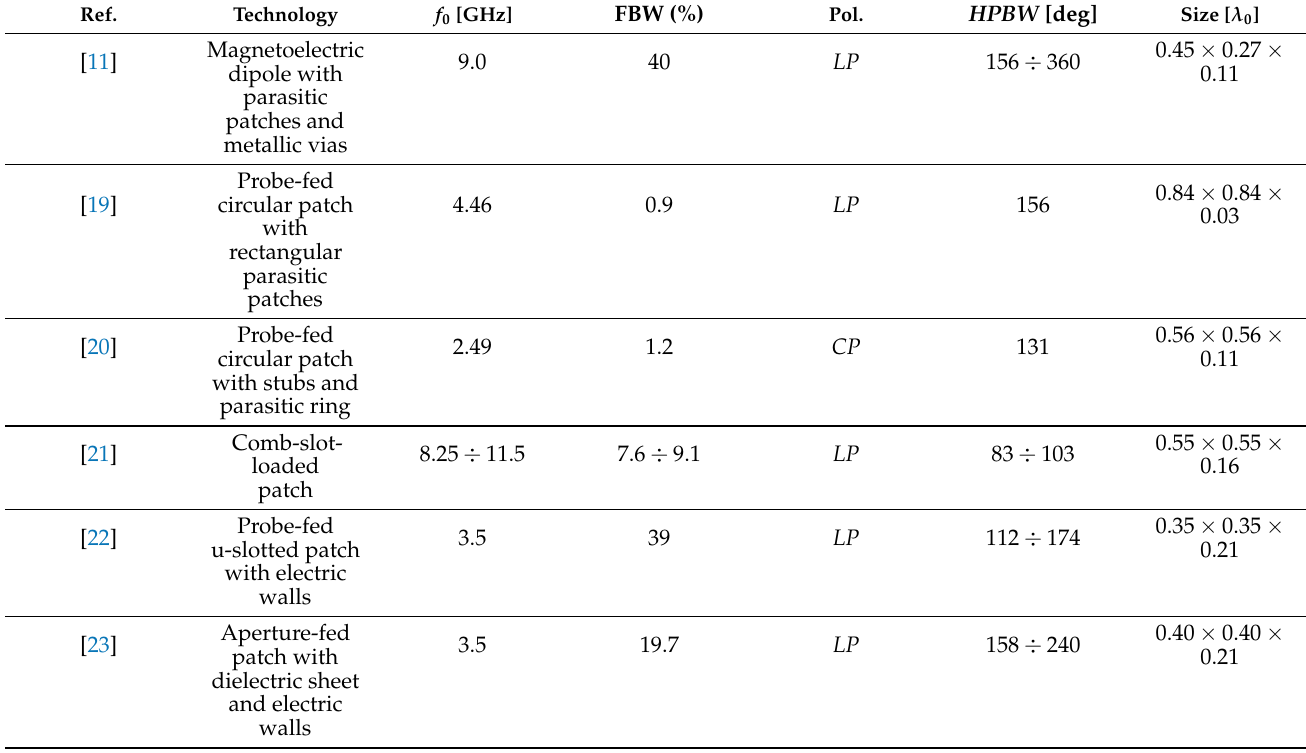
Table 1. Comparison in terms of central frequency ( f 0 ), fractional bandwidth ( FBW ), polarization, elevation HPBW at the central frequency, and overall size (in wavelengths at f 0 , λ 0 ), between the proposed WWCS antenna and wide-beam designs recently appeared in the scientific literature.